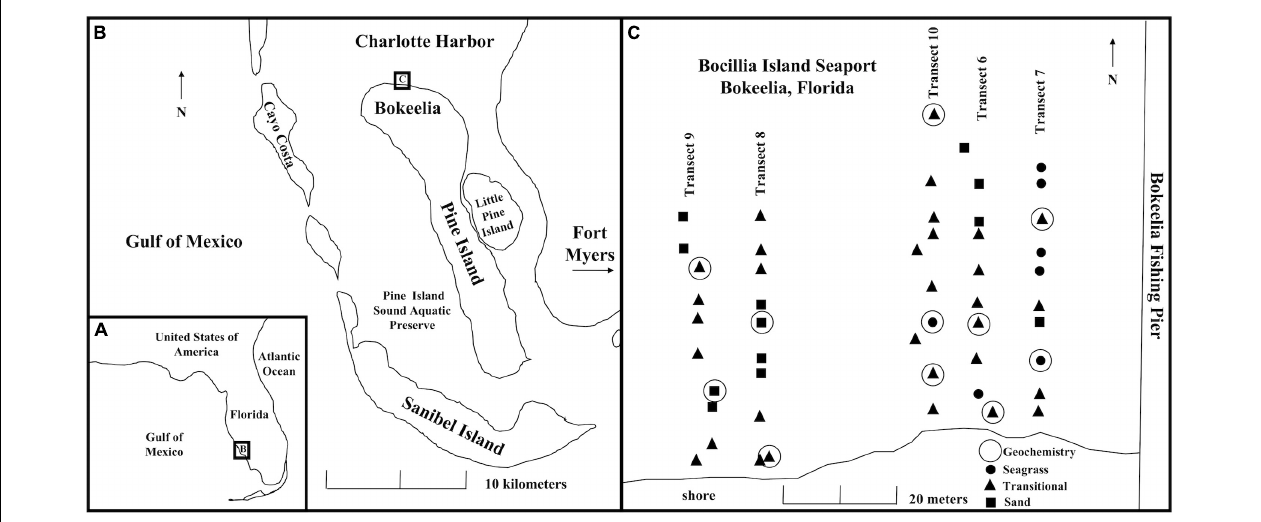
VPDB (Vienna Pee Dee Belemnite) scale. Analytical precision